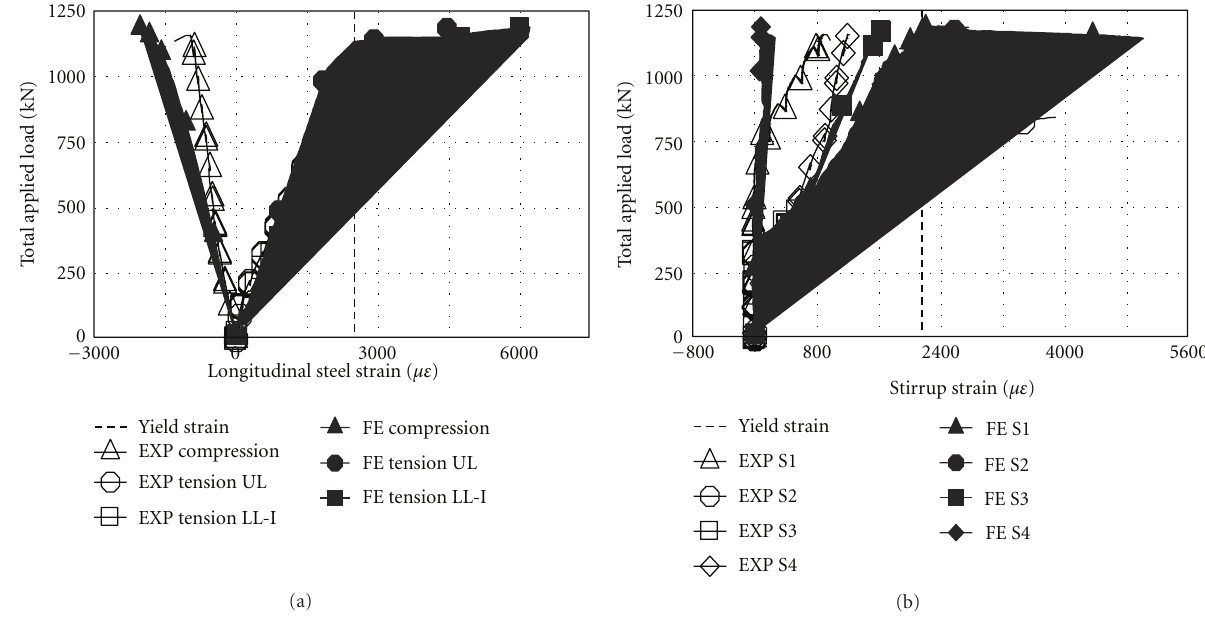
Figure 8: Experimental and predicted load-steel strain plots for (a) flexural steel and (b) stirrups for specimen 10RA and corresponding undamaged FE model.